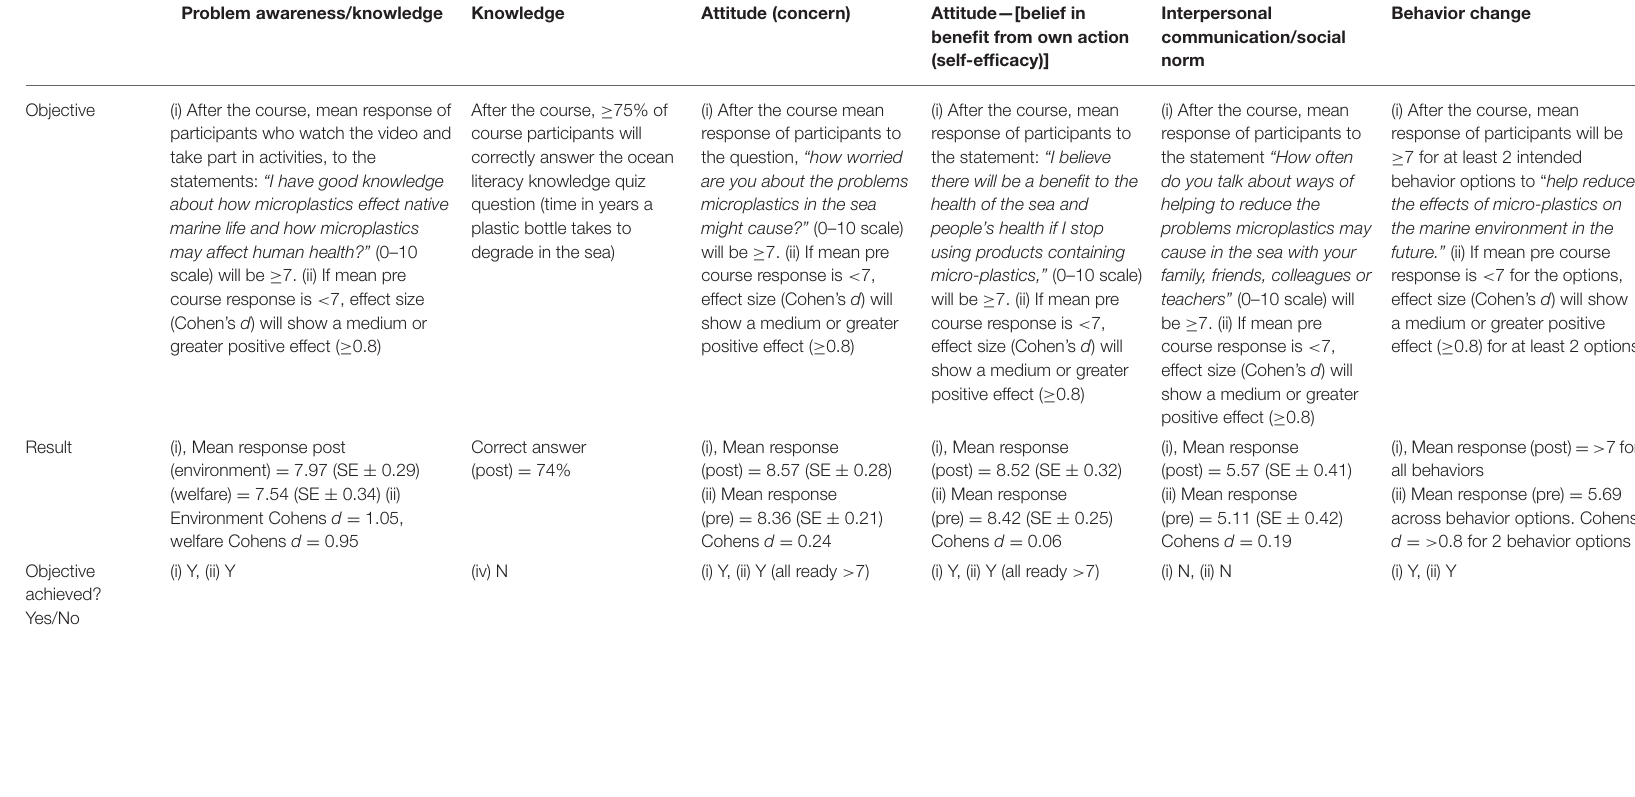
TABLE 7 | Summary of results of pre and post surveys in relation to objectives in the theory of change related to participants’ viewing the “Rethinking Plastic”